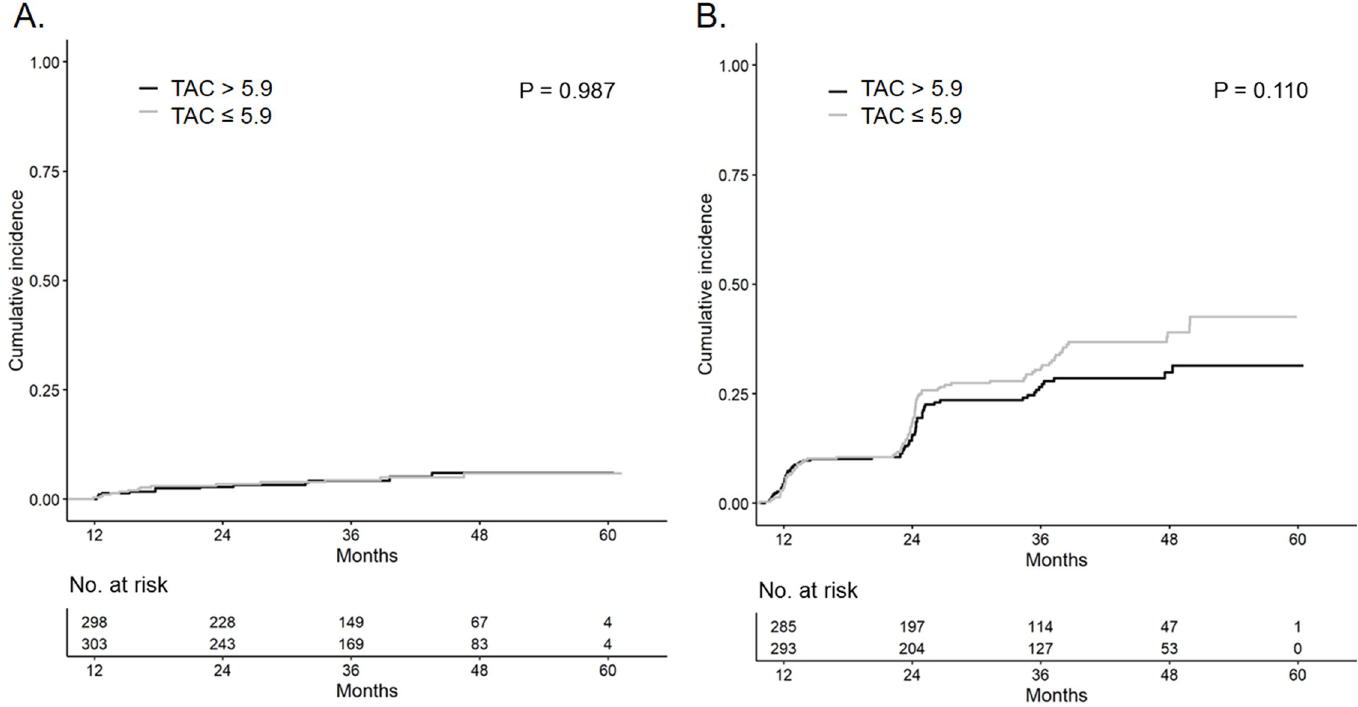
Fig 2. Cumulative incidence of (A) renal composite endpoints and (B) cardiovascular composite endpoints according to TAC trough levels. No significant differences in the development of renal and cardiovascular outcomes between the HL-TAC and LL-TAC groups were observed in the Kaplan-Meier plot. Abbreviations: LL, low-level; HL, high-level; TAC,